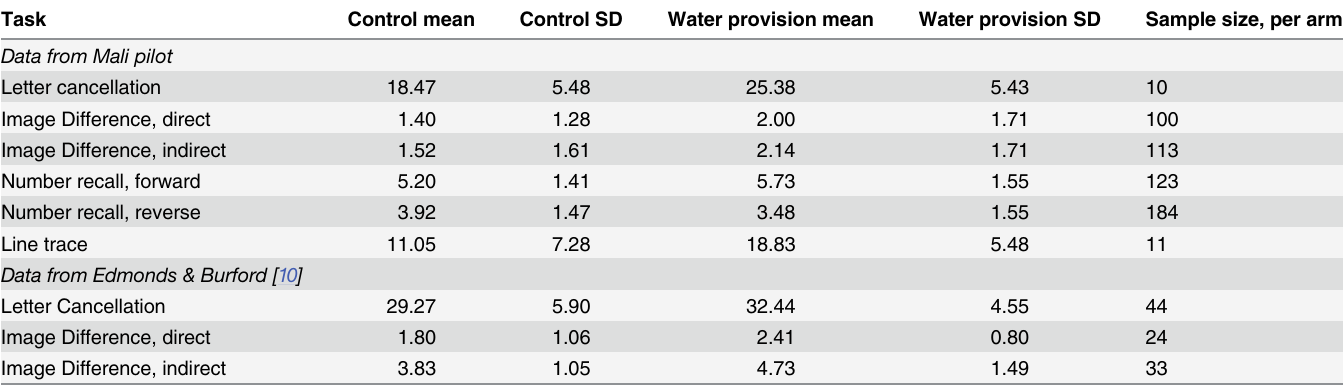
Table 1. Sample size